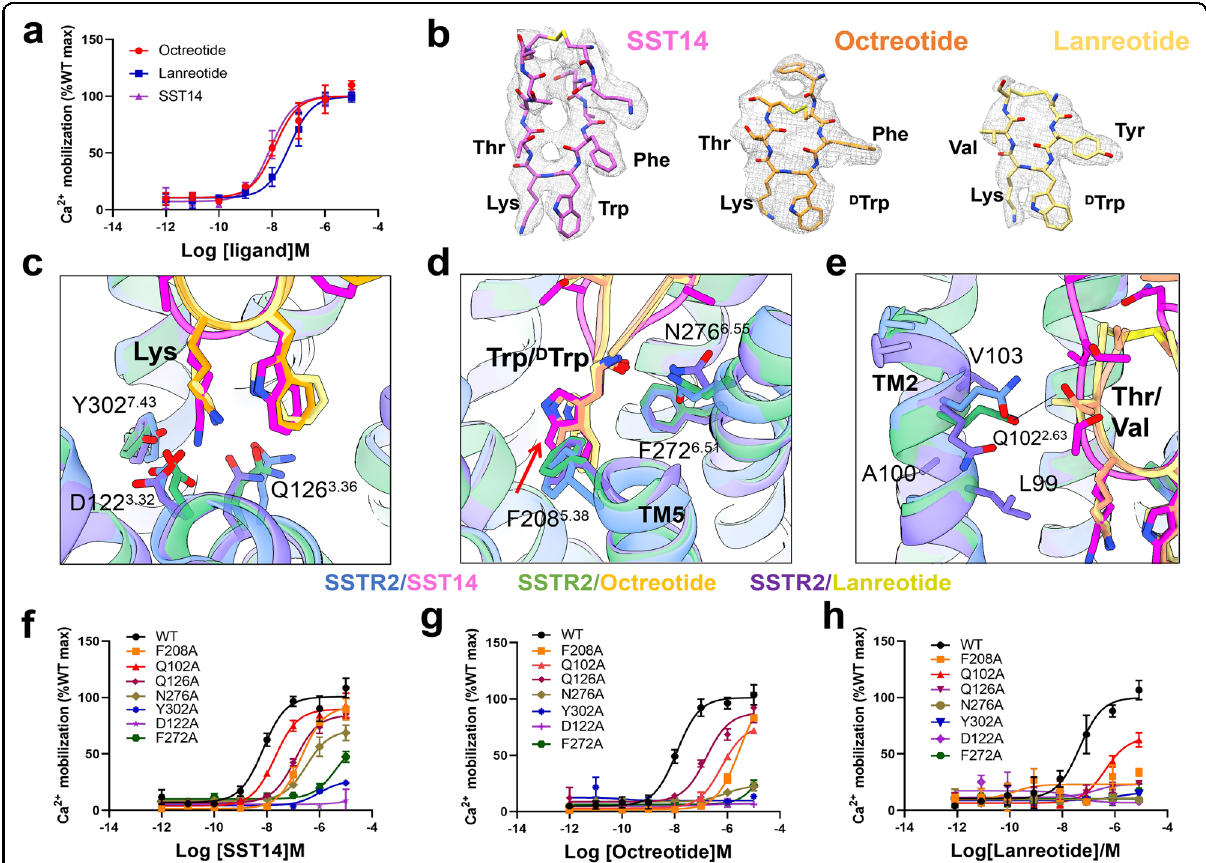
Fig. 2 Interactions between SST β -turn residues and SSTR2 transmembrane residues. a Ca 2 + response of SSTR2 with SST14, octreotide, and lanreotide. Data are presented as means ± SEM of three independent experiments conducted in triplicate. b Local density maps of SST14, octreotide and lanreotide. The conserved key binding amino acids are highlighted. c – e Superposition of the ligand-binding pockets of SST14- or octreotide- or lanreotide-bound SSTR2 receptor. f – h Ca 2 + accumulation analysis of wild-type (WT) SSTR2 and mutants with SST14 ( f ) or octreotide ( g ) or lanreotide ( h ). Site mutations around the ligand-binding pocket disrupted the receptor – ligand interactions, resulting in SSTR2 malfunction in the Ca 2 + accumulation assay. Data are presented as means ± SEM of three independent experiments conducted in